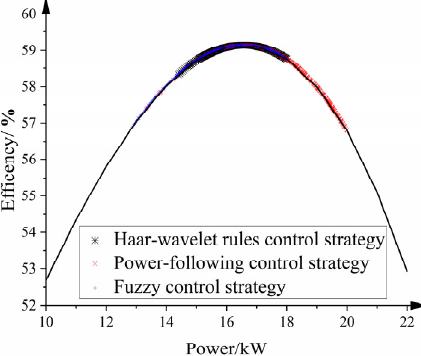
Figure 19. Comparison of actual operating points of hydrogen fuel cells with different control strategies. Table 2. Comparison of the efficiency of hydrogen fuel cells with different control strategies.